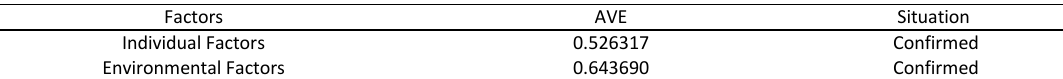
Fig. 3: Path coefficient and t-value Table 7. Mean extraction variance (convergent validity)